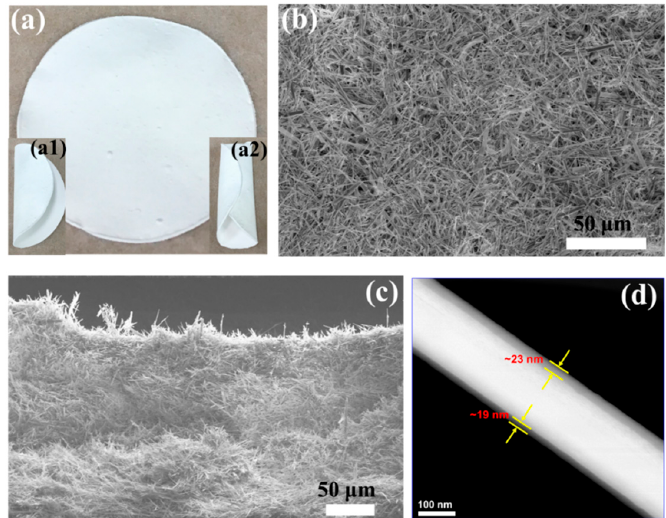
Figure 5. ( a ) Photograph of the membrane fabricated by using TiO 2 -coated HAp whiskers, with ( a1 ) and ( a2 ) inset photographs of the membrane after bending, FE-SEM images of ( b ) surface and ( c ) cross-section observations of the membrane, and ( d ) STEM images revealing the thickness of the TiO 2 coating layer for a single TiO 2 -coated HAp particle.